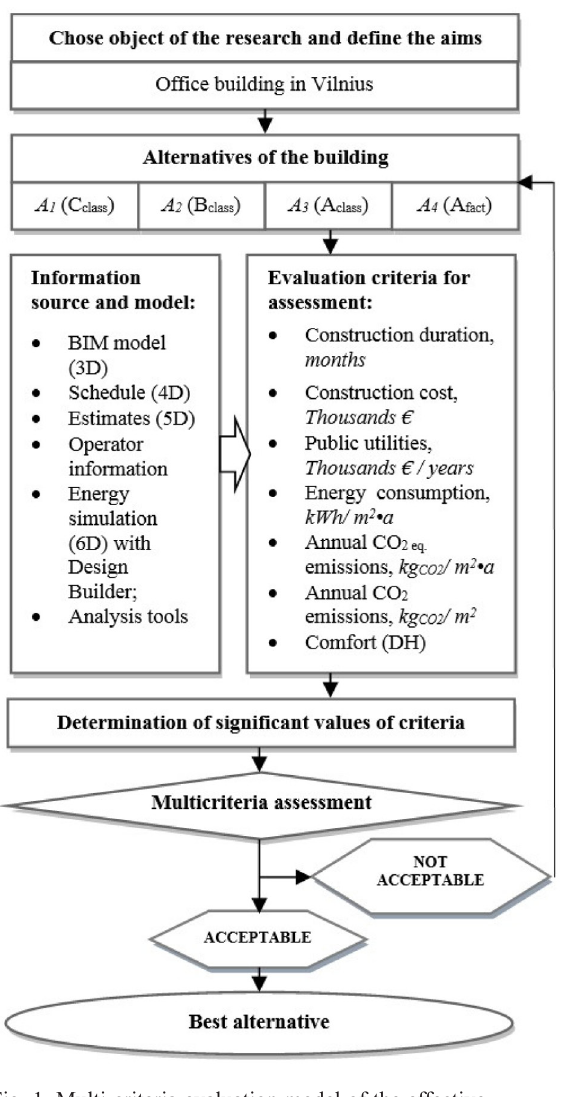
Fig. 1. Multi-criteria evaluation model of the effective building